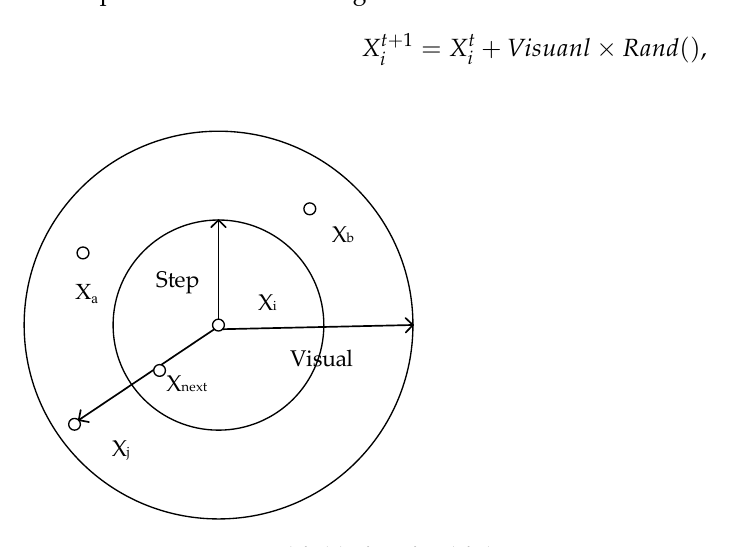
Table 1. DNA encoding and decoding